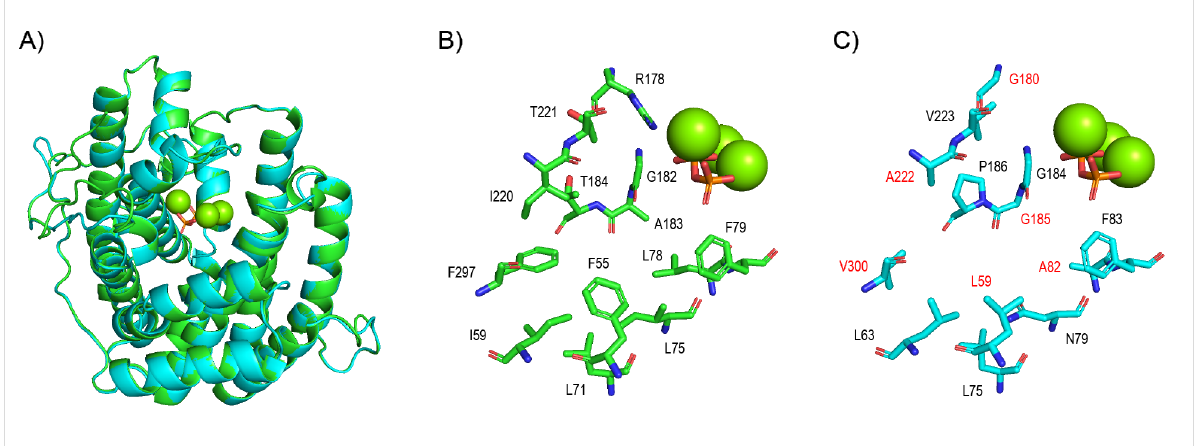
Figure 3: Swiss homology modelling of SmTS1. A) Superimposition of the SdS crystal structure (green) with the SmTS1 model (cyan). B) Active site residues of SdS. C) Active site residues of SmTS1. Active site residues that are smaller than in SdS are labelled in red. Green spheres represent Mg 2+ cations and orange/red sticks show complexed